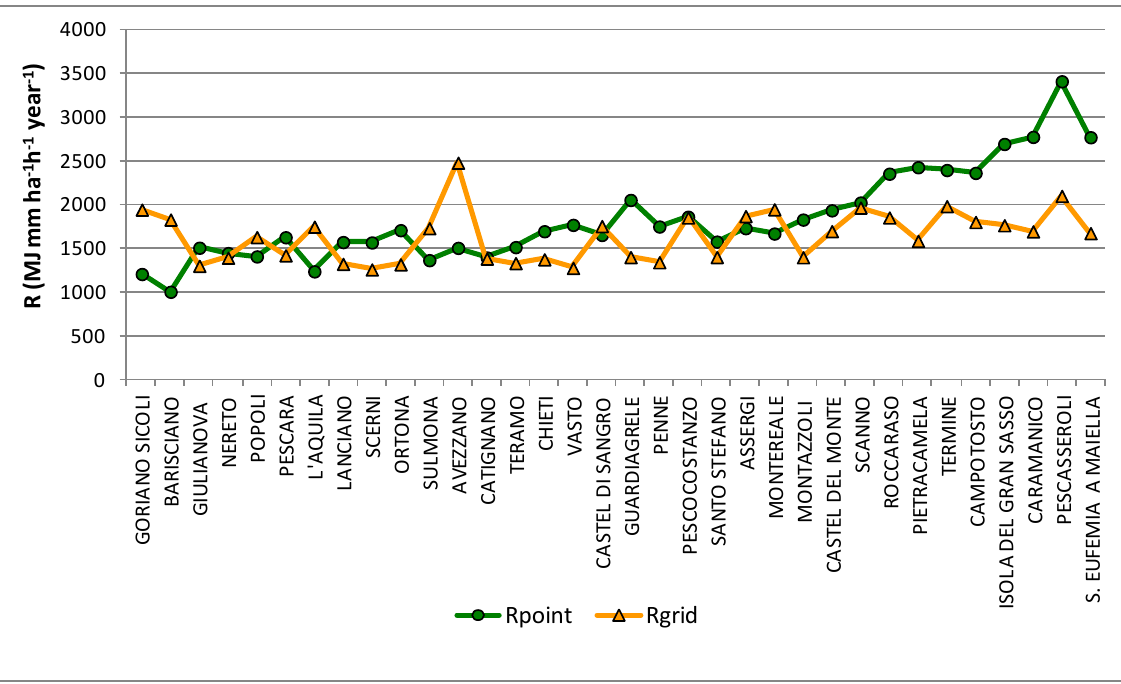
Figure 10. Comparison between mean annual erosivity factors (Equation (8)) obtained from point and grid precipitation datasets. Stations are represented in increasing order of mean annual precipitation (based on point dataset).